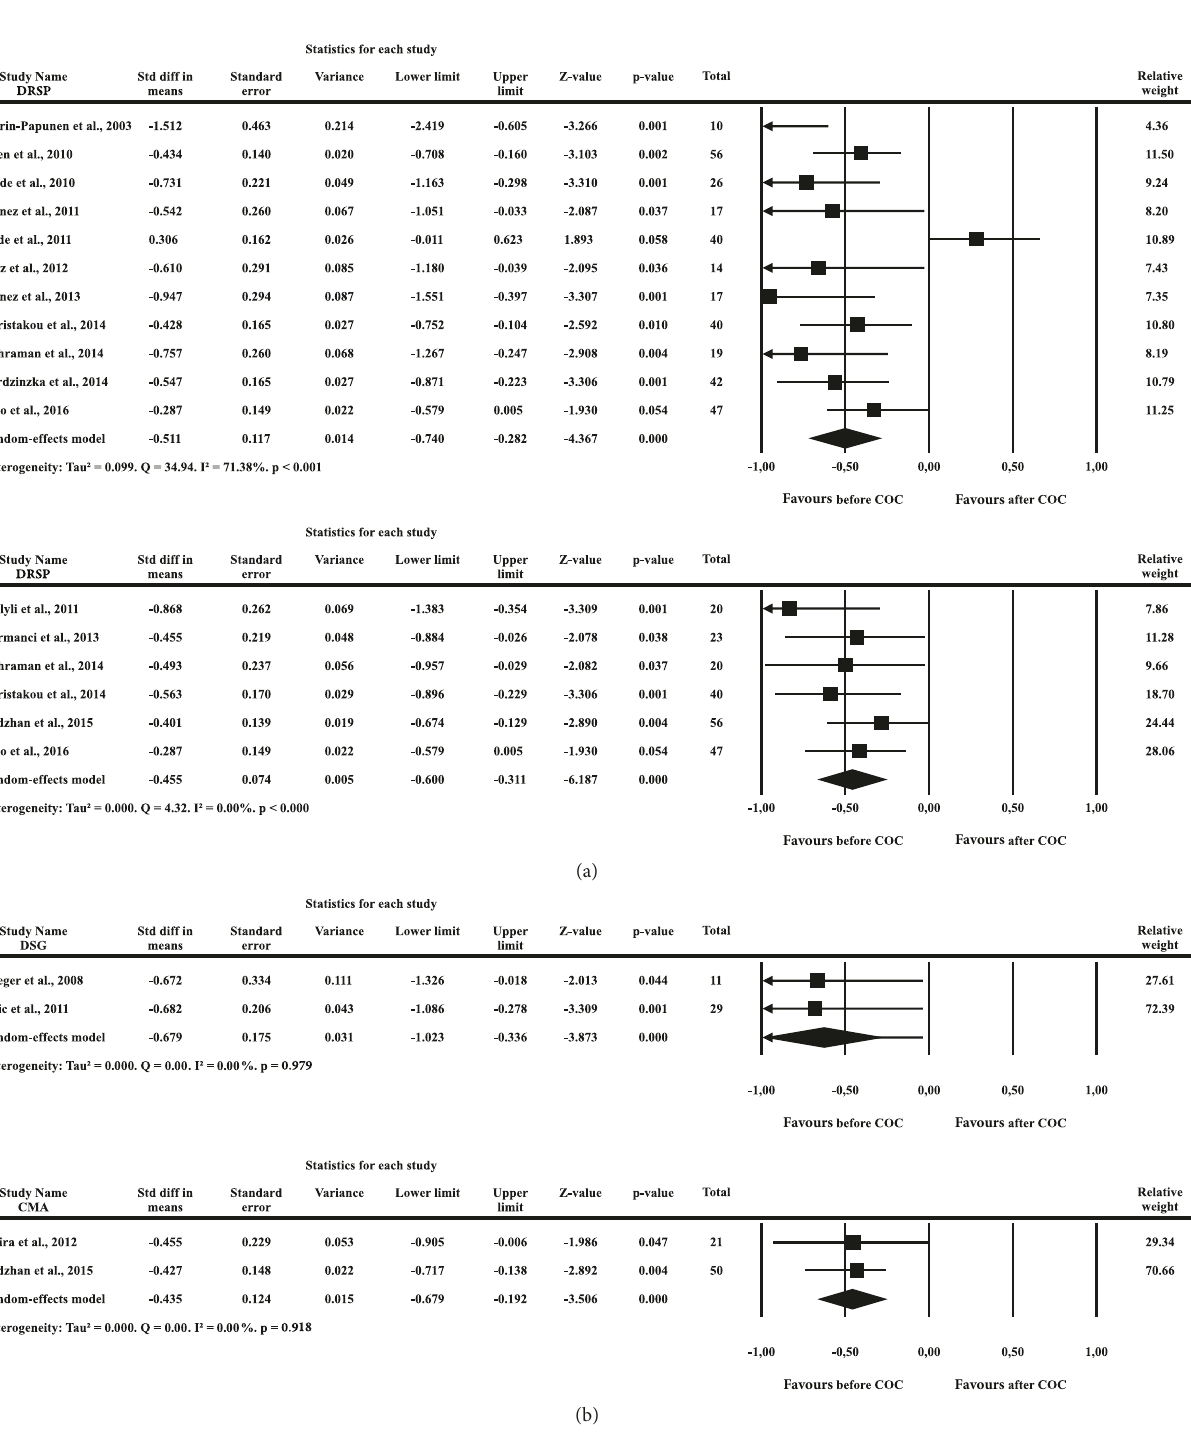
Figure 2: (a) Forest plot of the standardized difference means of C-reactive protein taken before and after the use of combined oral contraceptive in PCOS patients. (b) Forest plot of the standardized difference means of C-reactive protein taken before and after the use of combined oral contraceptive in PCOS